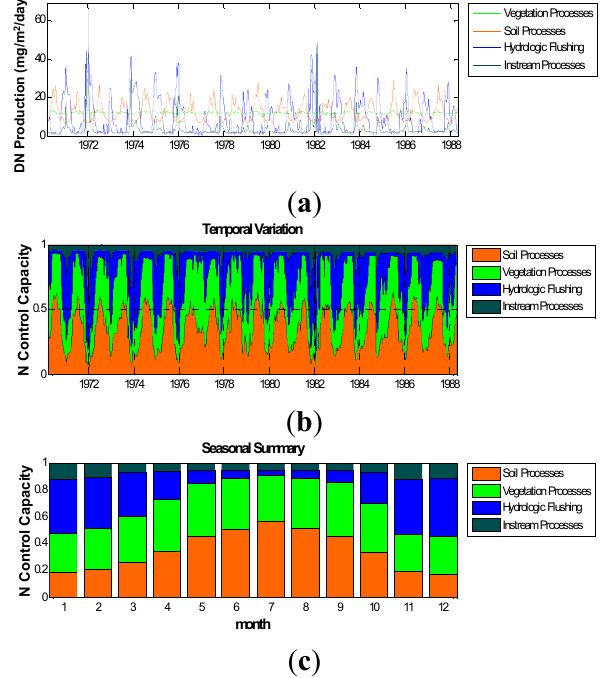
Figure 11. The nitrogen control capacity. ( a ) The plot outlines the summed rate terms which are used to estimate the control capacity of the watershed components as indicated in the legend. These four time series correspond directly to Equations (1)–(4); ( b ) The plot represents the control capacity, where the time series from the upper plot have been normalized by the total rate of nitrogen movement. ( c ) The plot represents the monthly averages of the control capacity, again including comparisons of the four different watershed